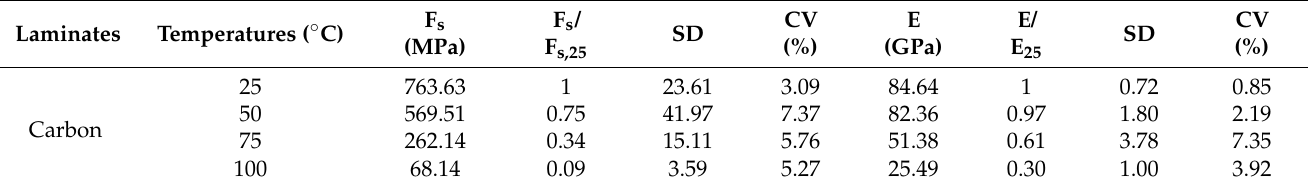
Table 3. Flexural strength (F s ) and modulus (E) properties of bidirectional carbon laminates under different temperatures.